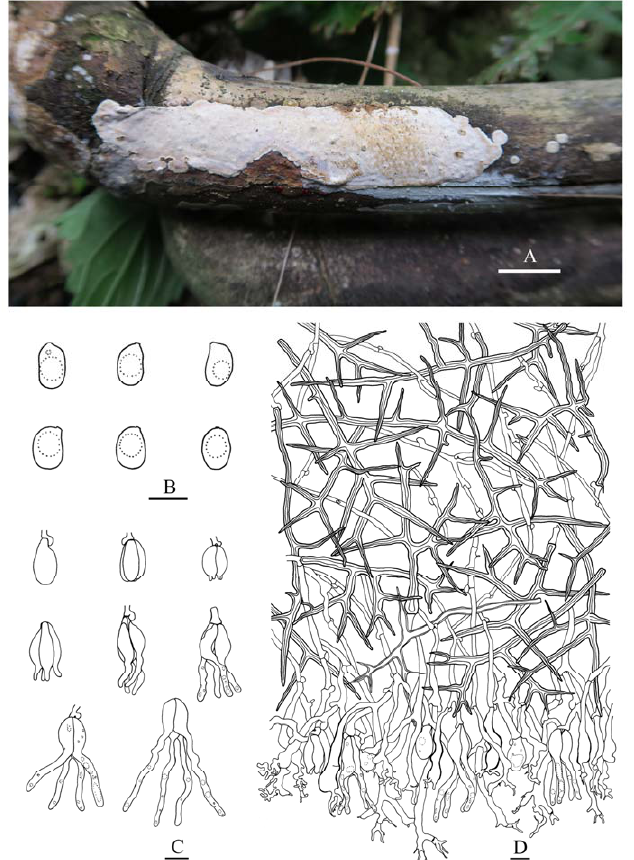
Figure 10. Eichleriella bambusicola (from the holotype, He 4073, BJFC 023514). Scale bars: ( A ) = 1 cm; ( B–D ) = 10 μ m. ( A ). Basidiomes; ( B ). Basidiospores; ( C ). Basidia; ( D ). A cross section of the basidiome.